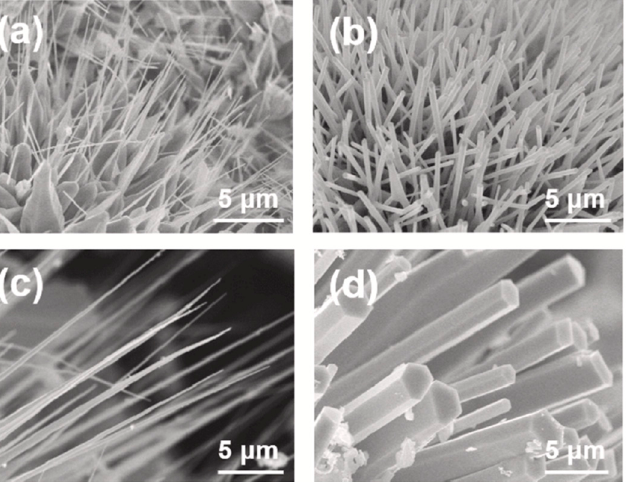
Figure 12. SEM Micrographs of ZnO nanowires at a different microwave input power of ( a ) 1 kW 0 slm, ( b ) 1.5 kW 0 slm, ( c ) 1 kW 3 slm and ( d ) 1.5 kW 3 slm. Reprinted with permission from [66]. Copyright (2021) Elsevier B.V.